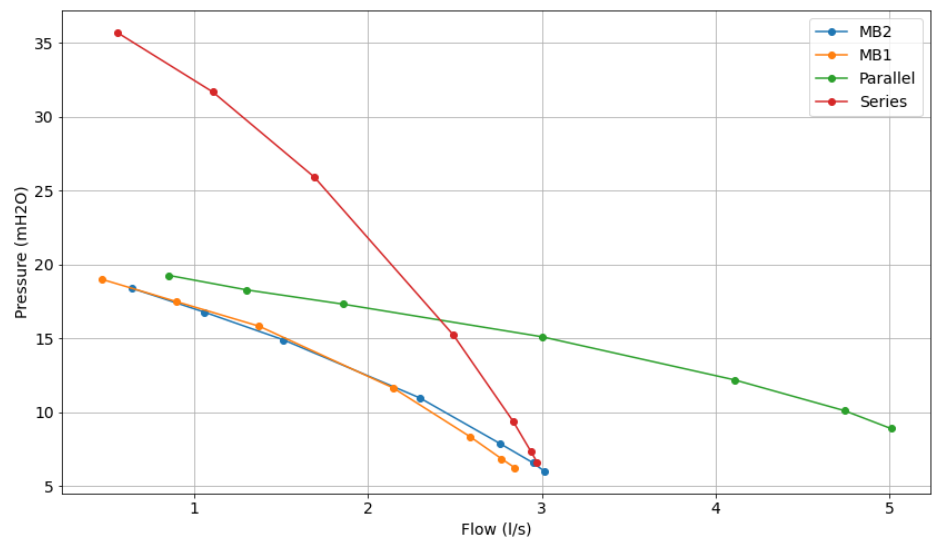
Figure 10. Comparative characteristic curve of pumps operating at 40 Hz.